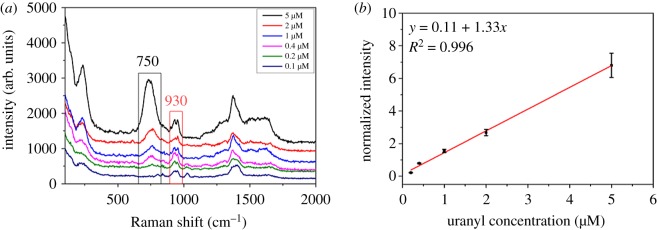
(a) SERS of uranyl ion with a concentration from 0.1 to 5 µM. (b) The calibration curve of uranyl ion concentration with its relative SERS intensity (Iuranyl/Icitrate) by citrate as the internal reference.